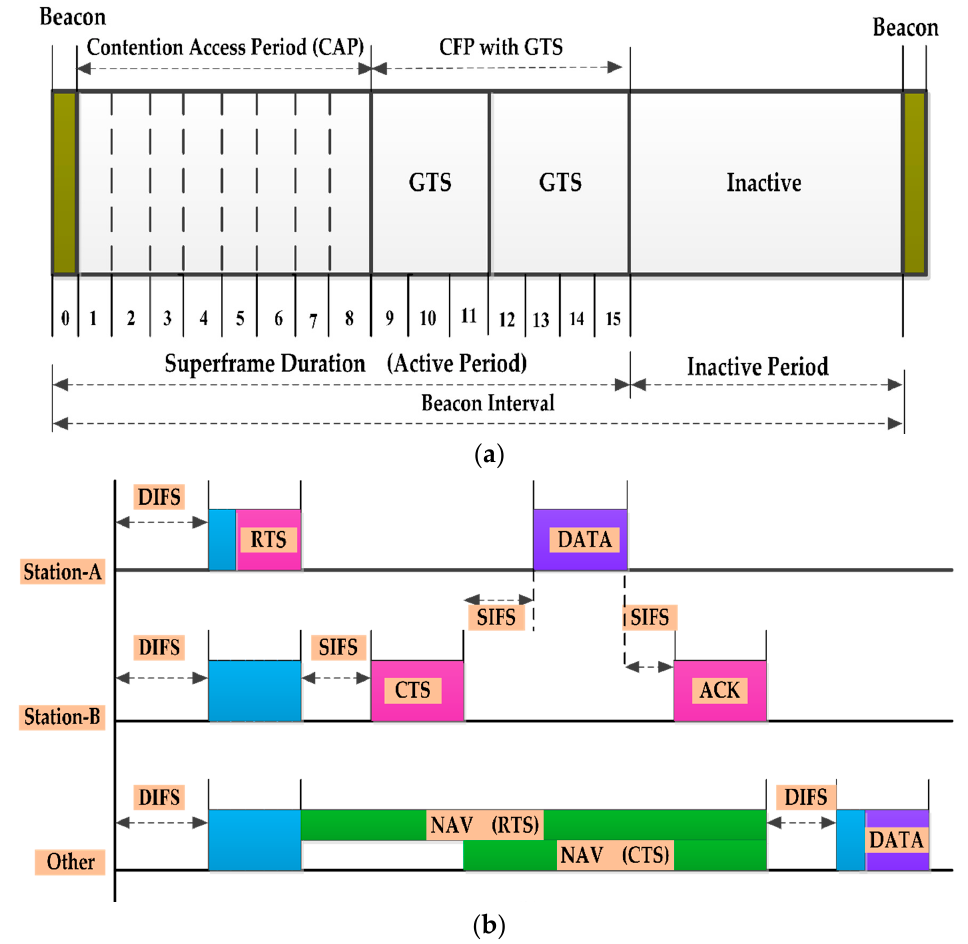
Figure 5. IEEE 802.11p ( a ) Superframe structure; ( b ) CSMA/CA process.